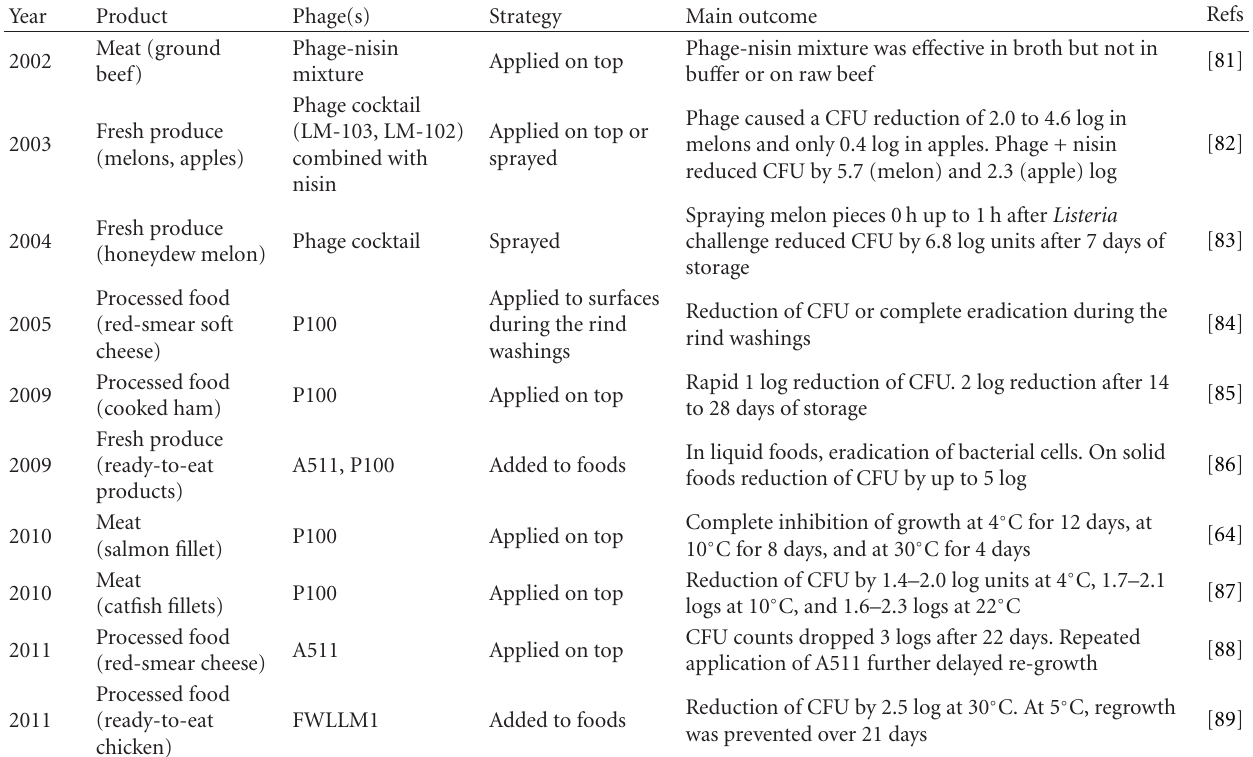
Table 4: Postharvest Listeria phage